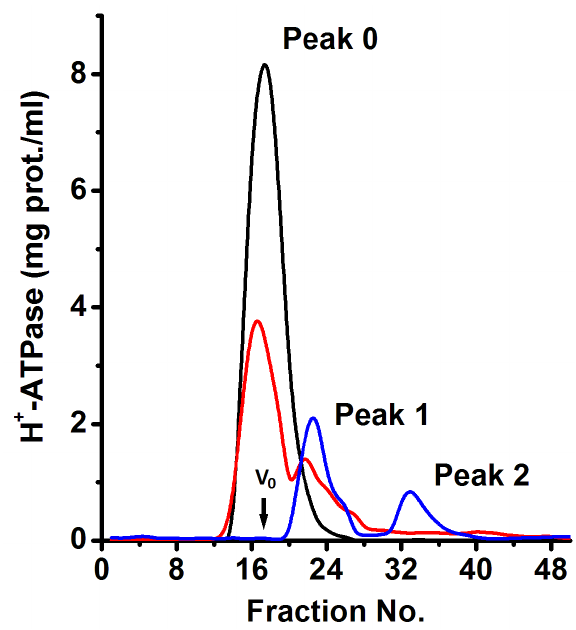
Figure 2. Macromolecular aggregated states (MASs) of the purified plasma membrane H + -ATPase from K. lactis . The purified H + -ATPase was subjected to size-exclusion chromatography using a Superose ® 6 chromatographic column and a flow rate of 0.25 mL/min as described in the methods section; chromatographic fractions (250 µ L) were collected every minute. The black, red, and blue lines correspond to 9, 6, and 3 mg of protein loaded on the chromatographic column, respectively. The void volume (v o ) is indicated. The absorbance ( λ of 280 nm) in collected fractions was determined and used to calculate the H + -ATPase concentration considering an extinction coefficient ( ε ) of 106,800 M − 1 · cm − 1 as described in methods.